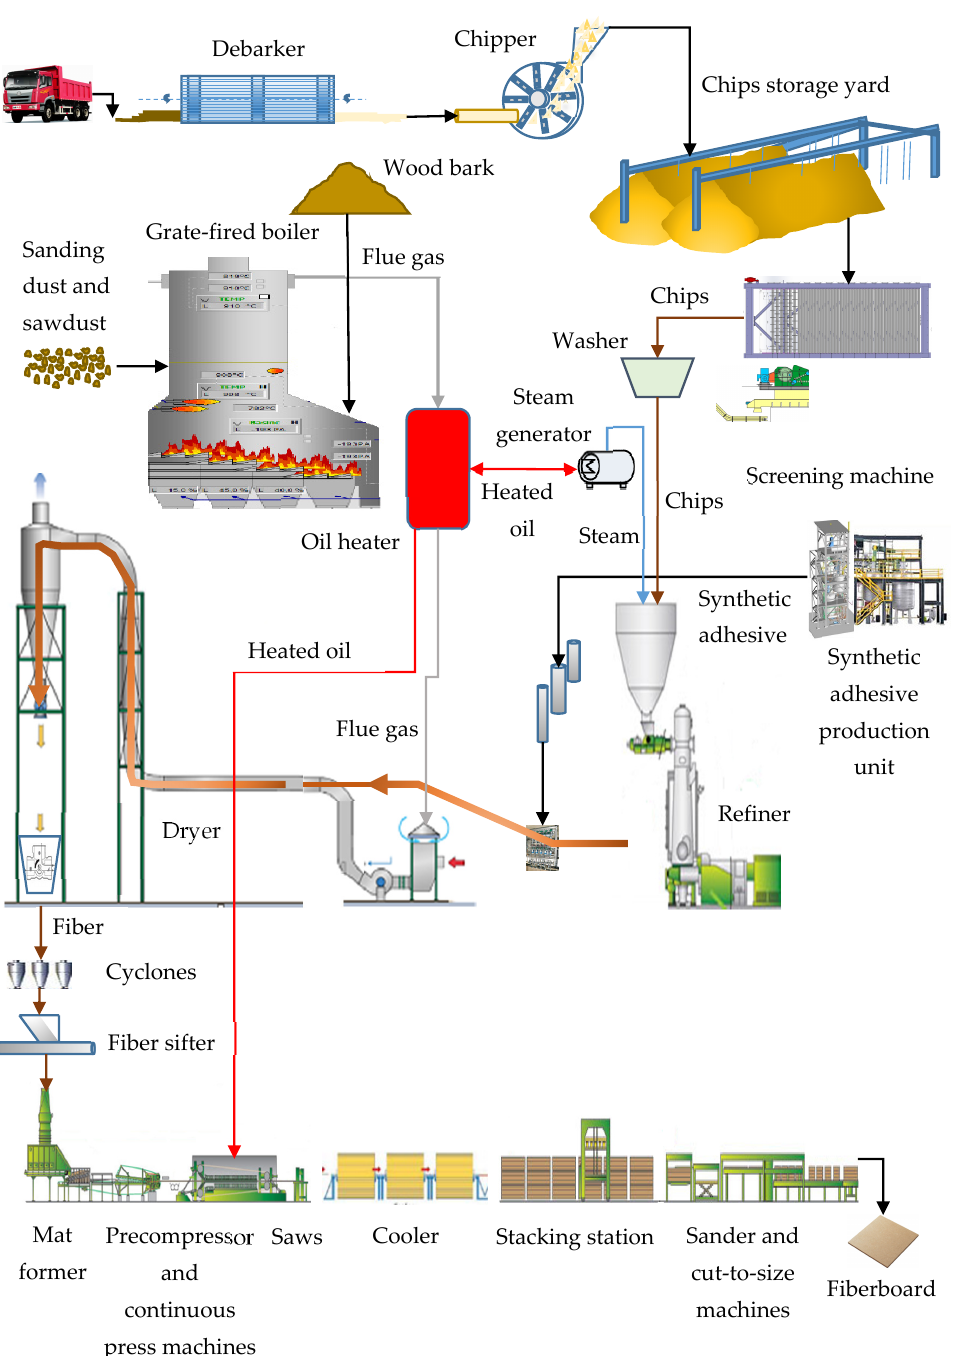
Figure 1. The flow chart of the fiberboard production line.